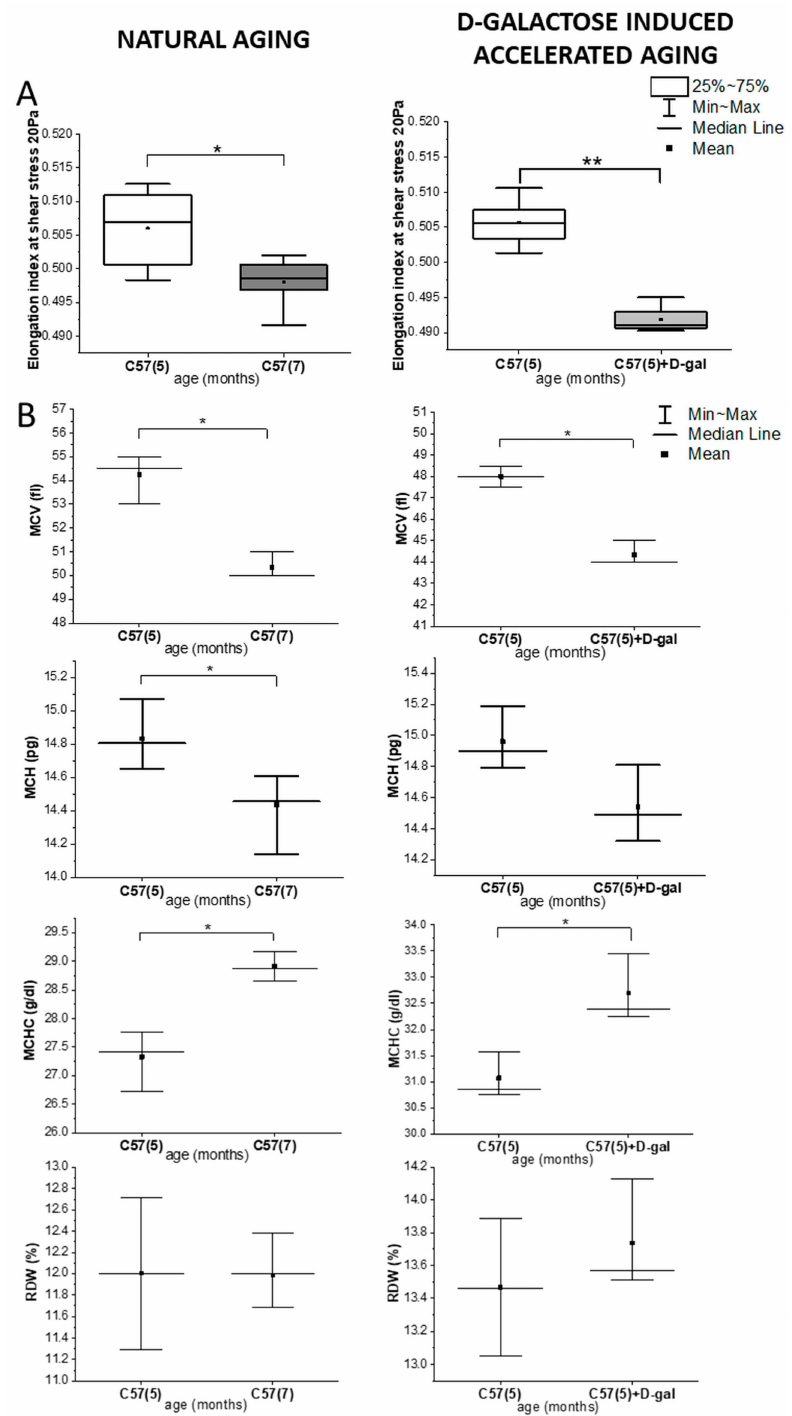
Figure 1. Rheological and morphological changes in the red blood cells (RBCs) in natural aging and the D-galactose (D-gal) model. ( A ) Changes in the elongation index at a shear stress of 20 Pa; and ( B ) the red blood cell indices, mean corpuscular volume (MCV), mean corpuscular hemoglobin (MCH), mean corpuscular hemoglobin concentration (MCHC), red cell distribution width (RDW), in naturally aging C57BL/6J mice (5- and 7-month-old male C57BL/6J mice, n = 4 and n = 3, respectively) and the D-galactose-induced accelerated aging mouse model (5 month-old C57BL/6J male mice, n = 3) with the control group (5 month-old C57BL/6J male mice, n = 3). Data distribution is presented as box plots (median and interquartile range, min–max whiskers) and interval plot (mean value, median, min-max whiskers). Statistical significance of the obtained values was tested with a Mann–Whitney test (* p < 0.05; ** p <